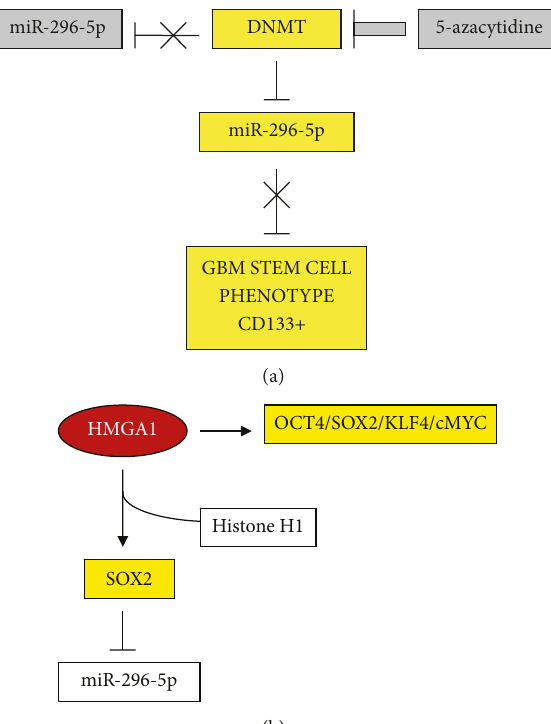
Figure 10: HMGA1 participation in stem cell establishment. (a) DNMTs repress miR-296-5p which can no longer repress the GBM stem cell phenotype. The inhibition of DNMTs by 5-azacytidine no longer blocks miR-296-5p and stem cells are not induced. (b) HMGA1 stimulates the expression of four master pluripotent factors and,withparticularefficiency,SOX2whichinhibitsmiR-296-5pand allows stem cell establishment. Symbols are the same as shown in Figure